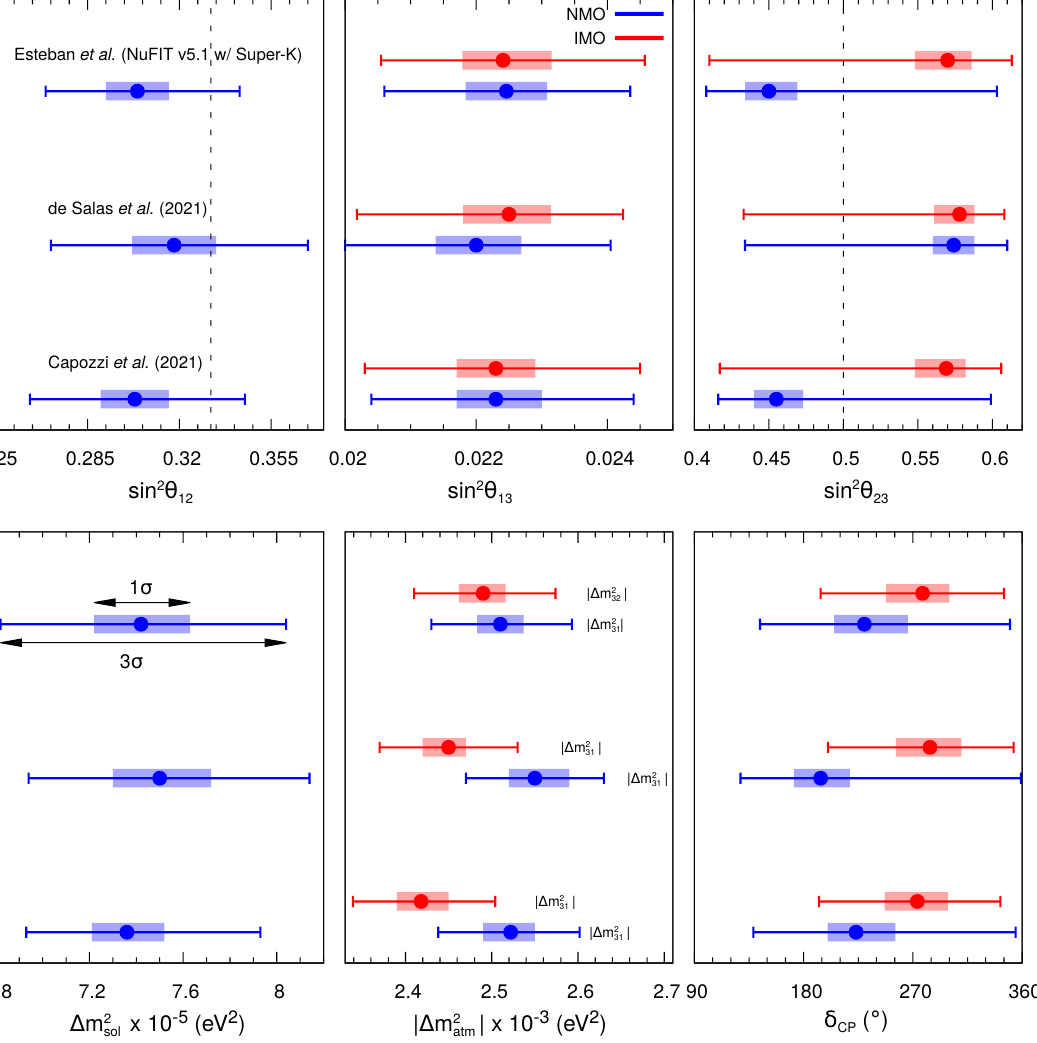
Figure 1 . Current 1 σ (see rectangular boxes) and 3 σ (see horizontal lines) allowed ranges of the neutrino oscillation parameters obtained from the global fit studies performed by Esteban et al. [9], de Salas et al. [10], and Capozzi et al. [11]. The blue (red) lines and boxes represent the values for NMO (IMO). In each panel, the best-fit value of respective oscillation parameter is shown by blue (red) dots for NMO (IMO). Vertical black dashed lines in the panels related to sin 2 θ show their corresponding values in the tri-bimaximal mixing scheme. Note that the measurements of sin 2 θ and ∆ m 2 ( ≡ ∆ m 2 ) are not sensitive to the choice of mass 12 21 sol